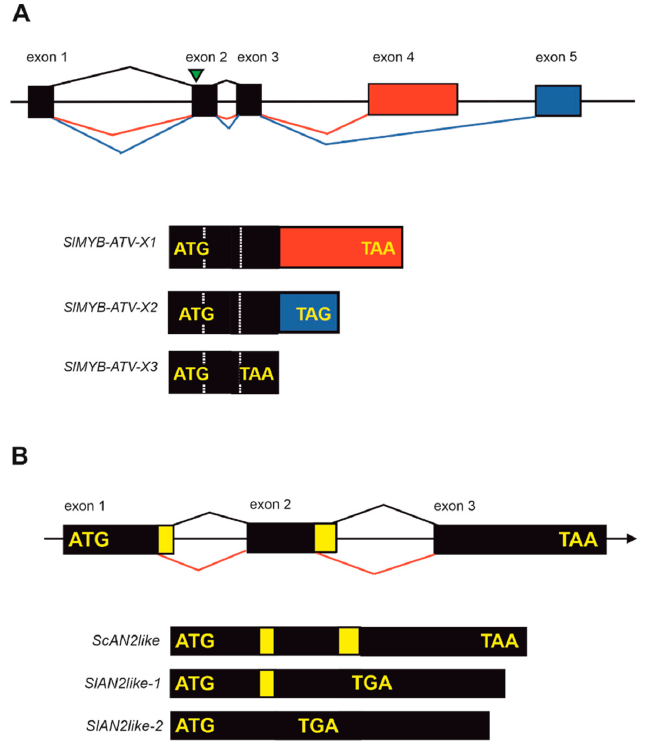
Figure 5. ( A ) Exon-intron structure of SlMYBV-ATV gene with possible alternative splicing variants. The relative three different transcripts which can be spliced from the gene ( SlMYB-ATV-X1 , SlMYB- ATV-X2 , and SlMYB-ATV-X3 ) are reported with the relative start and stop codons. The first three exons, represented in black, are the bioinformatically predicted ones for the gene. The green triangle indicates the position of the 4-nt insertion identified in the gene in the atv mutant genotype. ( B ) Exon-intron structure of AN2like gene with the two possible 5 ′ splicing variants. The transcript produced from the Solanum chilense allele ( ScAN2like ) identified in the Aft tomato accession is reported as well as the two differently spliced transcripts produced in Solanum lycopersicum ( SlAN2like-1 and SlAN2like-2 ), which both show premature stop codons.